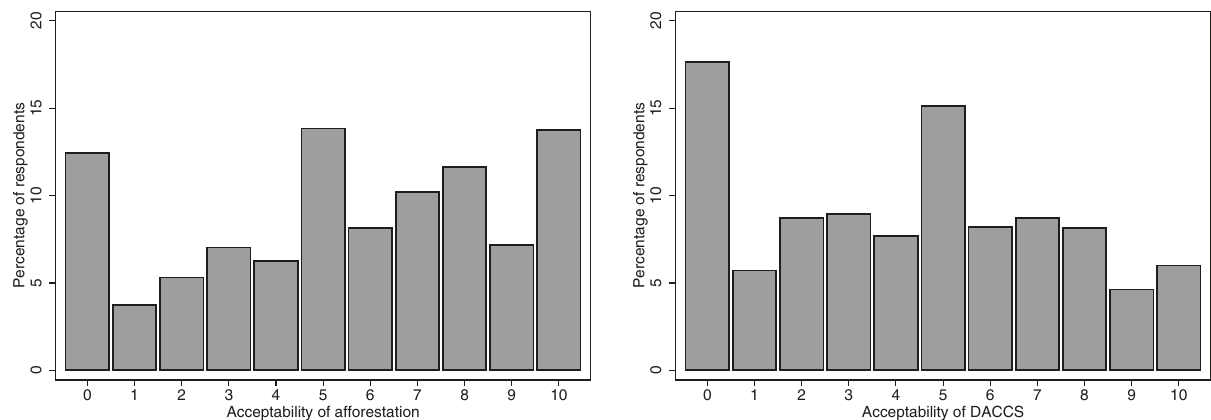
Fig. 3 Acceptability of afforestation or DACCS across vignettes. The percentage of respondents who chose a response category from 0 ( “ strongly oppose ” ) to 10 ( “ strongly support ” ) in the vignette evaluation task for afforestation and DACCS; n = 5067 vignette evaluations per CDR method from n = 1689 respondents.